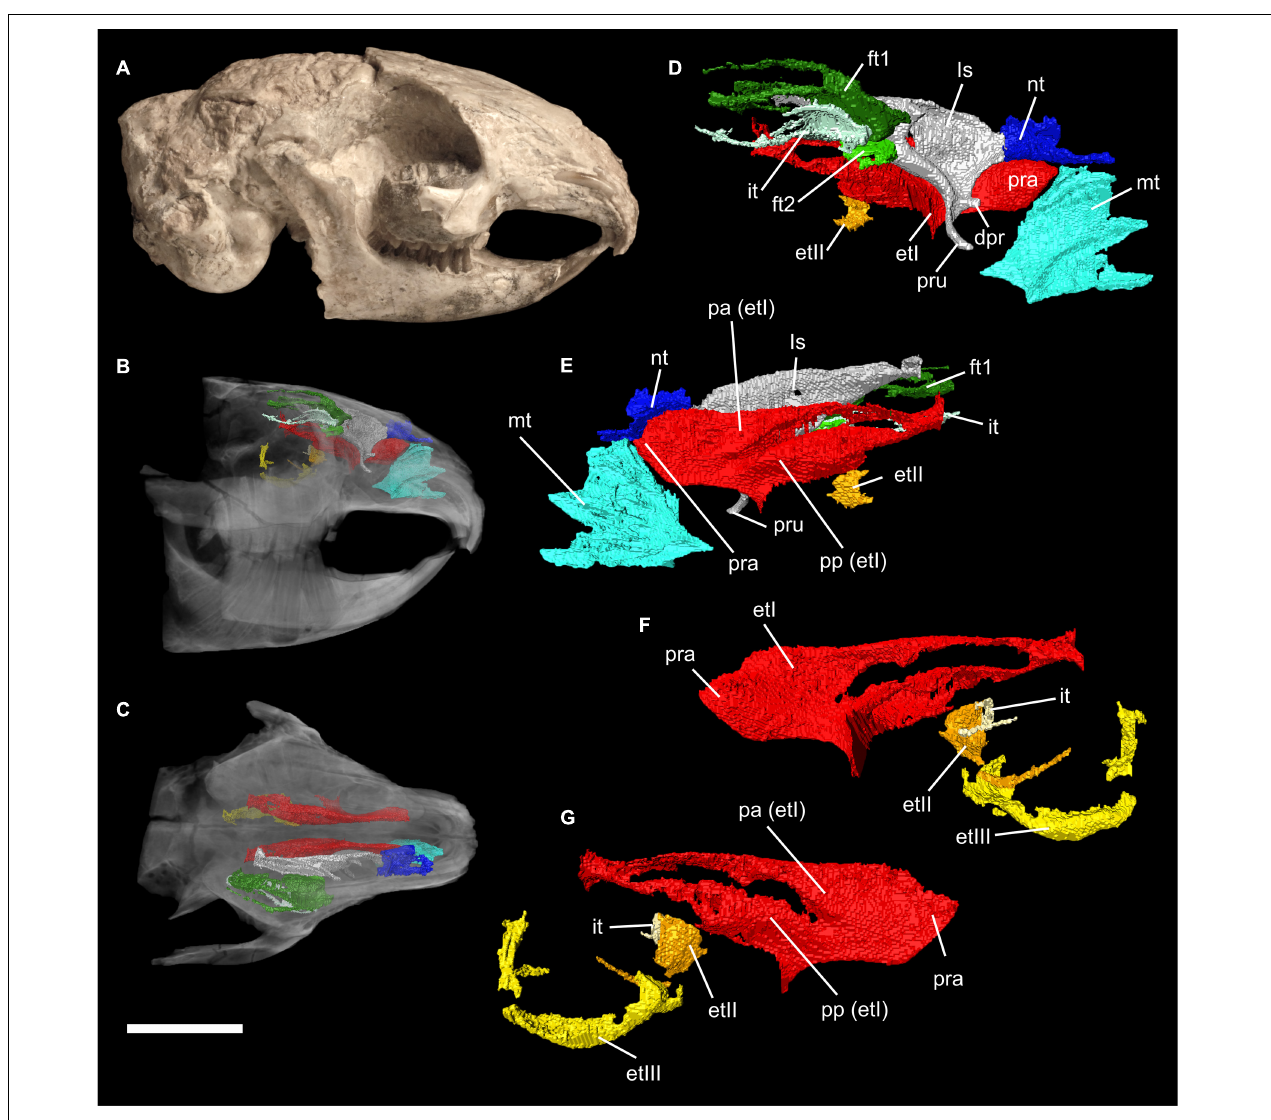
FIGURE 1 | Virtual 3D reconstructions of the turbinal skeleton of Palaeolagus haydeni (FMNH PM9476). Actual skull in mirrored lateral view (A) . Rostrum with highlighted turbinal skeleton in lateral (B) and dorsal (C) views. The skull bones are transparent. Right turbinal skeleton in lateral (D) and medial (E) views. The ethmoturbinals are incomplete. Left turbinal skeleton in lateral (F) and medial (G) views. Only the fronto- ethmo-, and interturbinals are reconstructed. Abbreviations: et I-III, ethmoturbinal I-III; dpr, dorsal process; ft 1-2, frontoturbinal 1-2; it, interturbinal; ls, lamina semicircularis; mt, maxilloturbinal; nt, nasoturbinal; pa, pars anterior; pp, pars posterior; pra, processus anterior; pru, processus uncinatus. Scale bar = 10 mm refers to (A–C) ; (D–G) not to